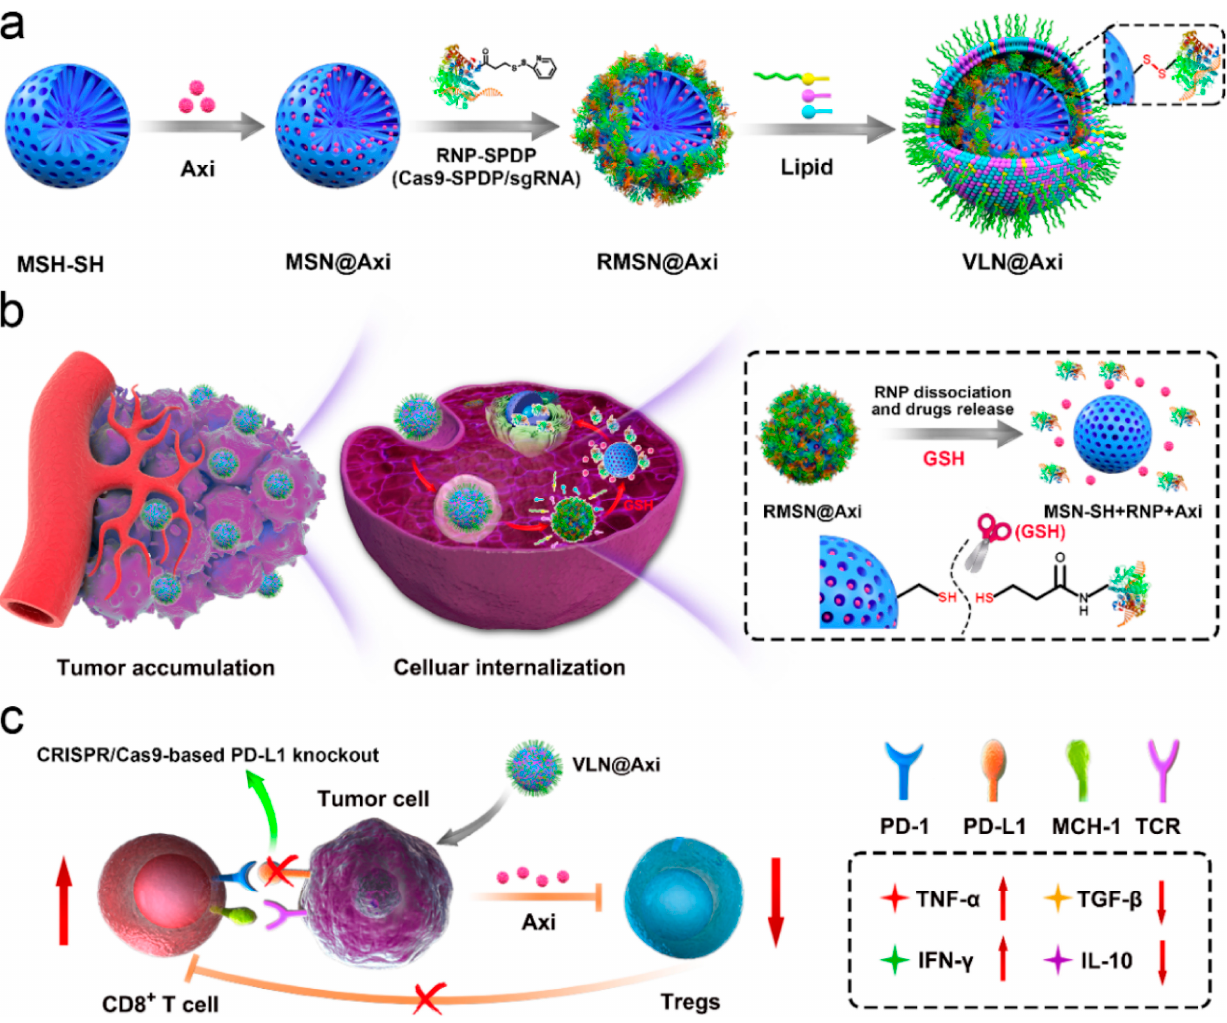
Figure 11. Schematic representation of the ( a ) synthesis, ( b ) delivery process, and ( c ) mode of action of VLPs designed by Liu et al. Reprinted with permission from [133]. Copyright 2020, Elsevier. Ab-